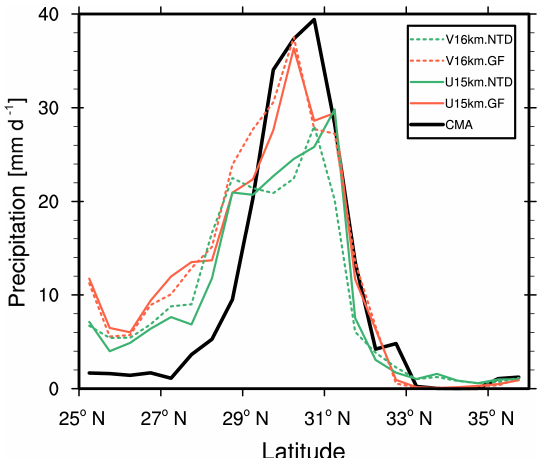
Figure 3. Zonal distributions of precipitation averaged during the event (25 June 00:00UTC to 27 June 12:00UTC) averaged over East China (denoted as the black box in Fig. 2) from the CMA sta- tion observations and the simulations with global uniform (15km, solid lines) and variable (16km over the refined region as shown in Fig. 1c, dashed lines) resolutions with two convective parameteri- zations (GF, red lines; NTD, green lines). The modeling results are sampled at the CMA